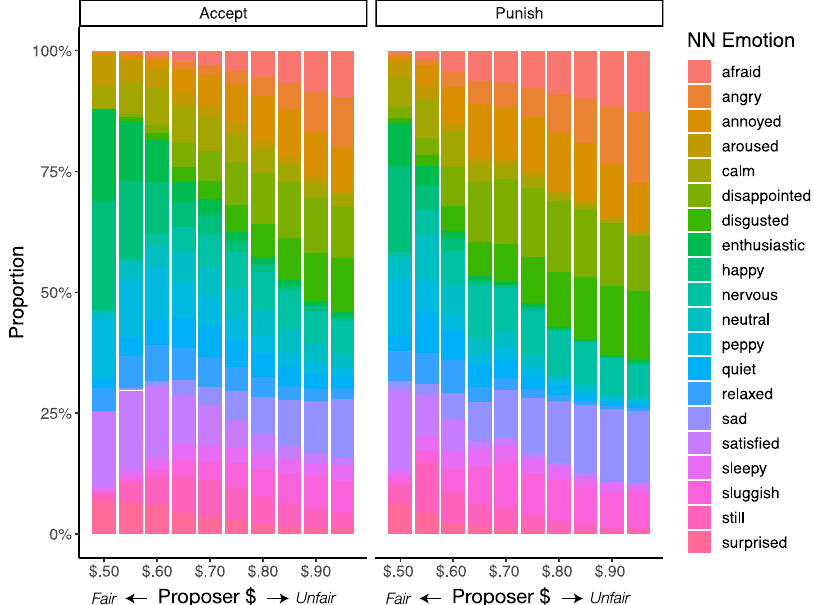
Fig. 6 Neural network classi fi cations across unfairness levels. Unfairness indexes the amount of money kept by the Proposer (out of $1) and ranges from fair ($0.50, $0.50) to highly unfair offers ($0.95, $0.05). The proportion refers to the model likelihood of each emotion class within participants ( N = 715), and then across choice (accept or punish) and each unfairness